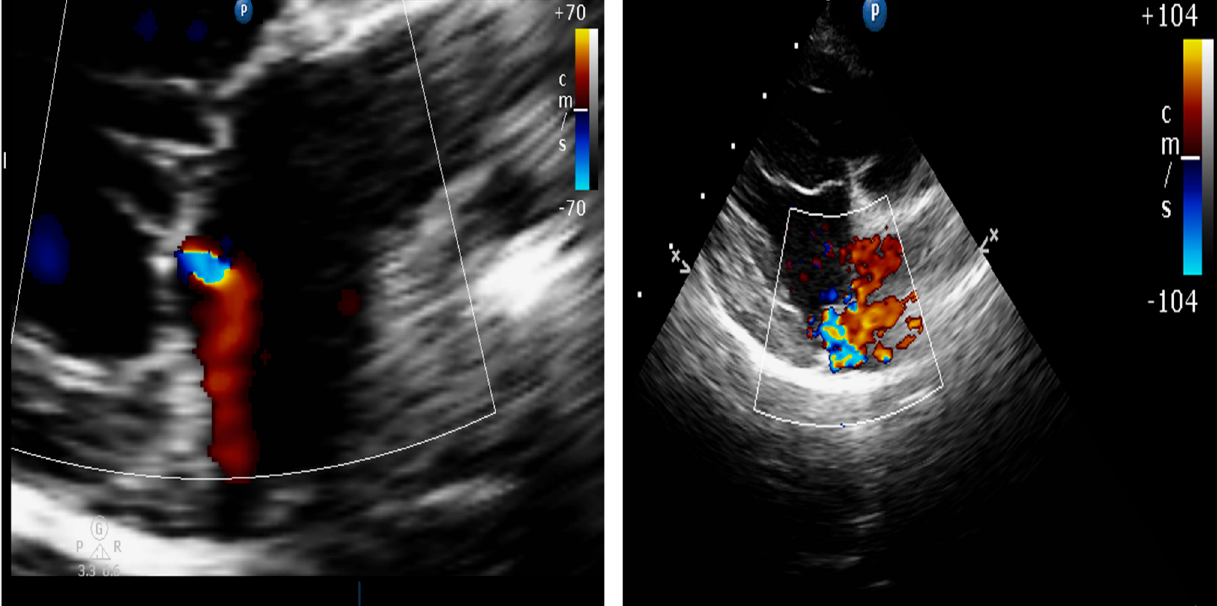
Figure 8. Mitral regurgitation in dogs due to myxomatous degeneration. Di ff erent degrees of valvular degeneration.